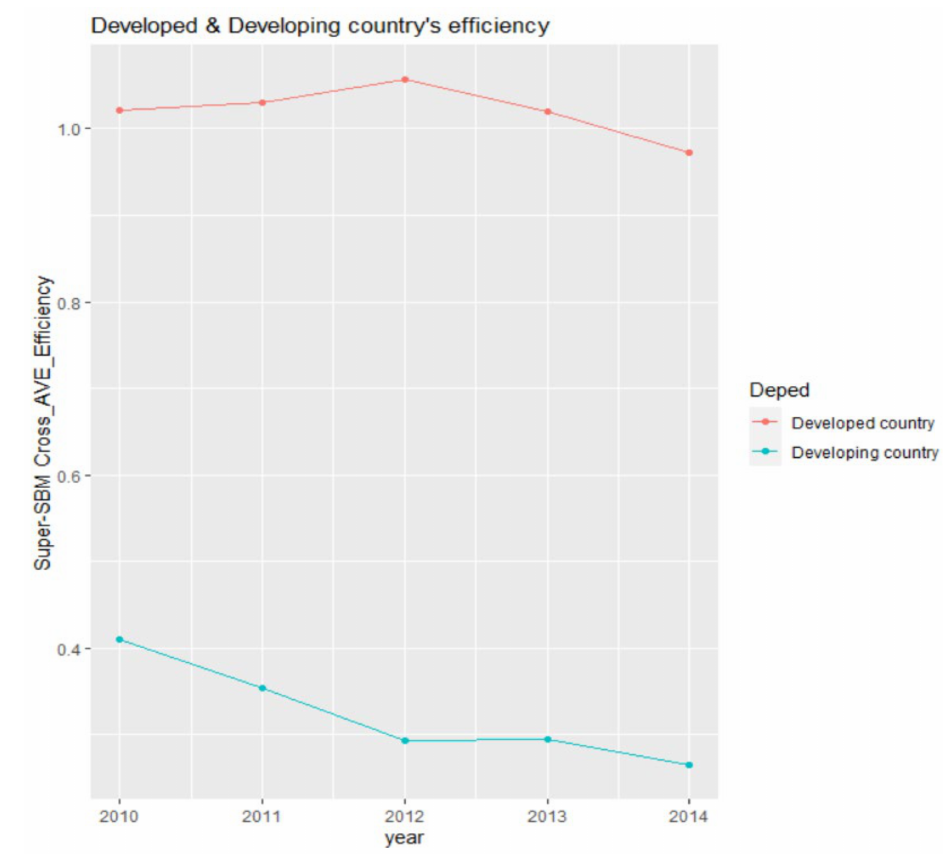
Figure 2. Comparison of CROSS AVE between developed countries and developing